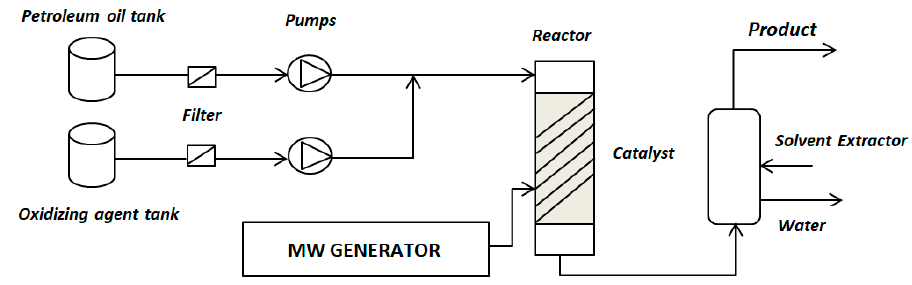
Figure 7. Scheme of continuous system for microwave oxidative desulfurization (ODS) process.